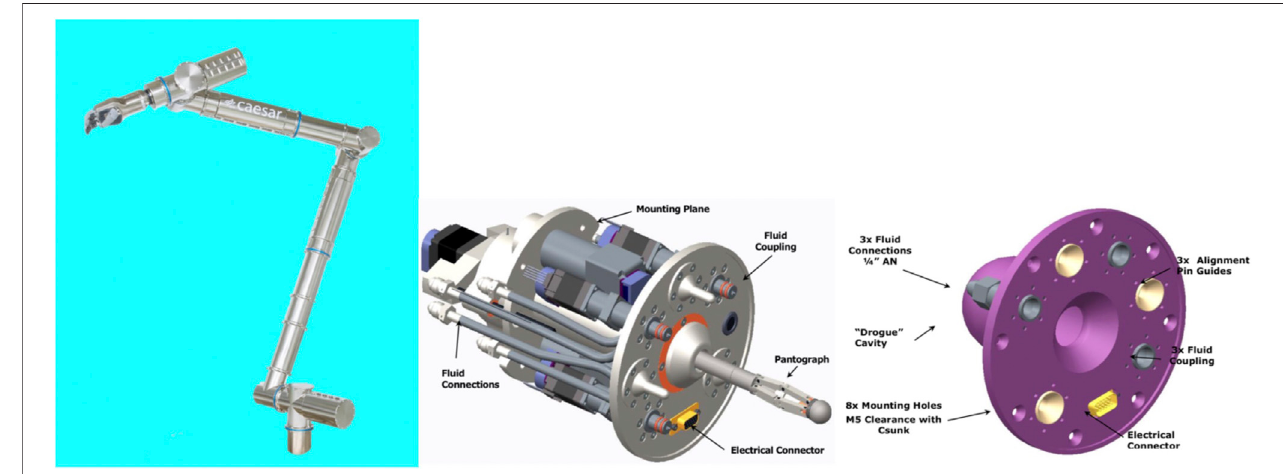
FIGURE 12 | (A) CAESAR robot arm with SpaceHand (DLR), (B) ASSIST mechanism for refueling satellites (ESA).